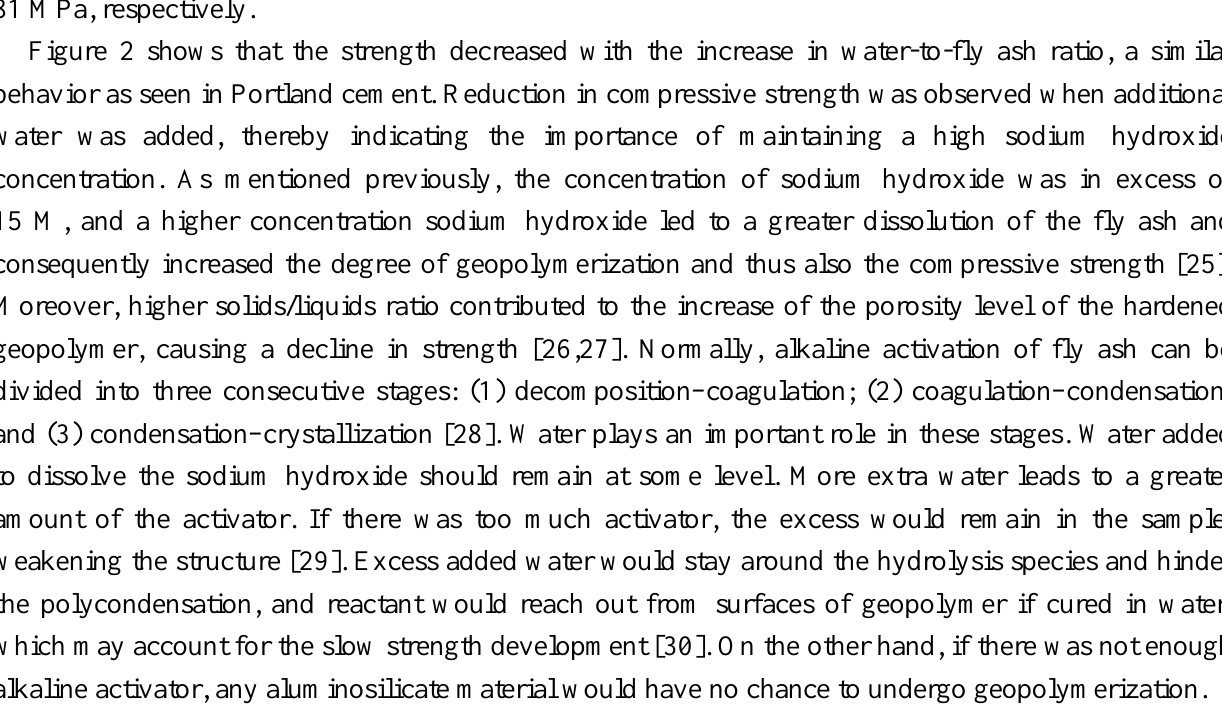
Figure 2. Compressive strength of paste and mortar with different water-to-fly ash